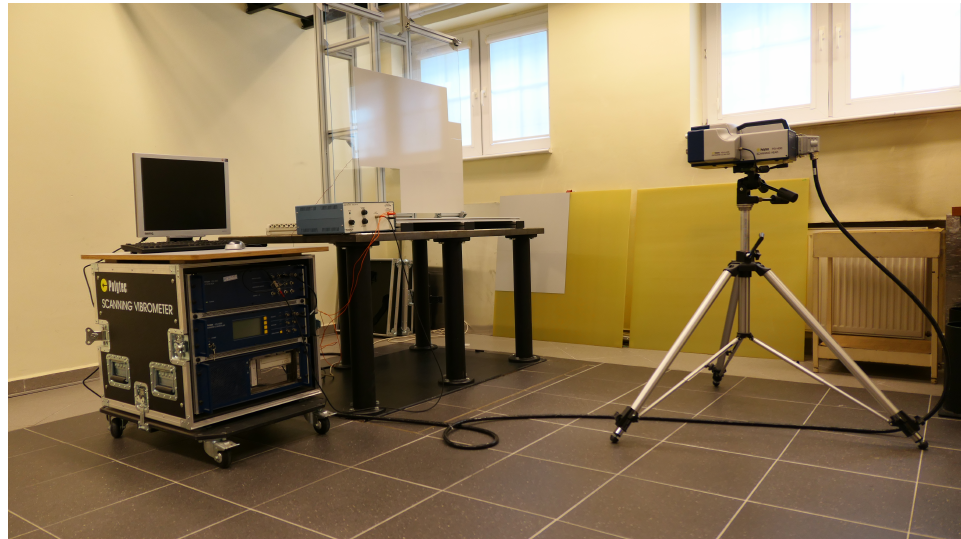
Figure 2. Experimental